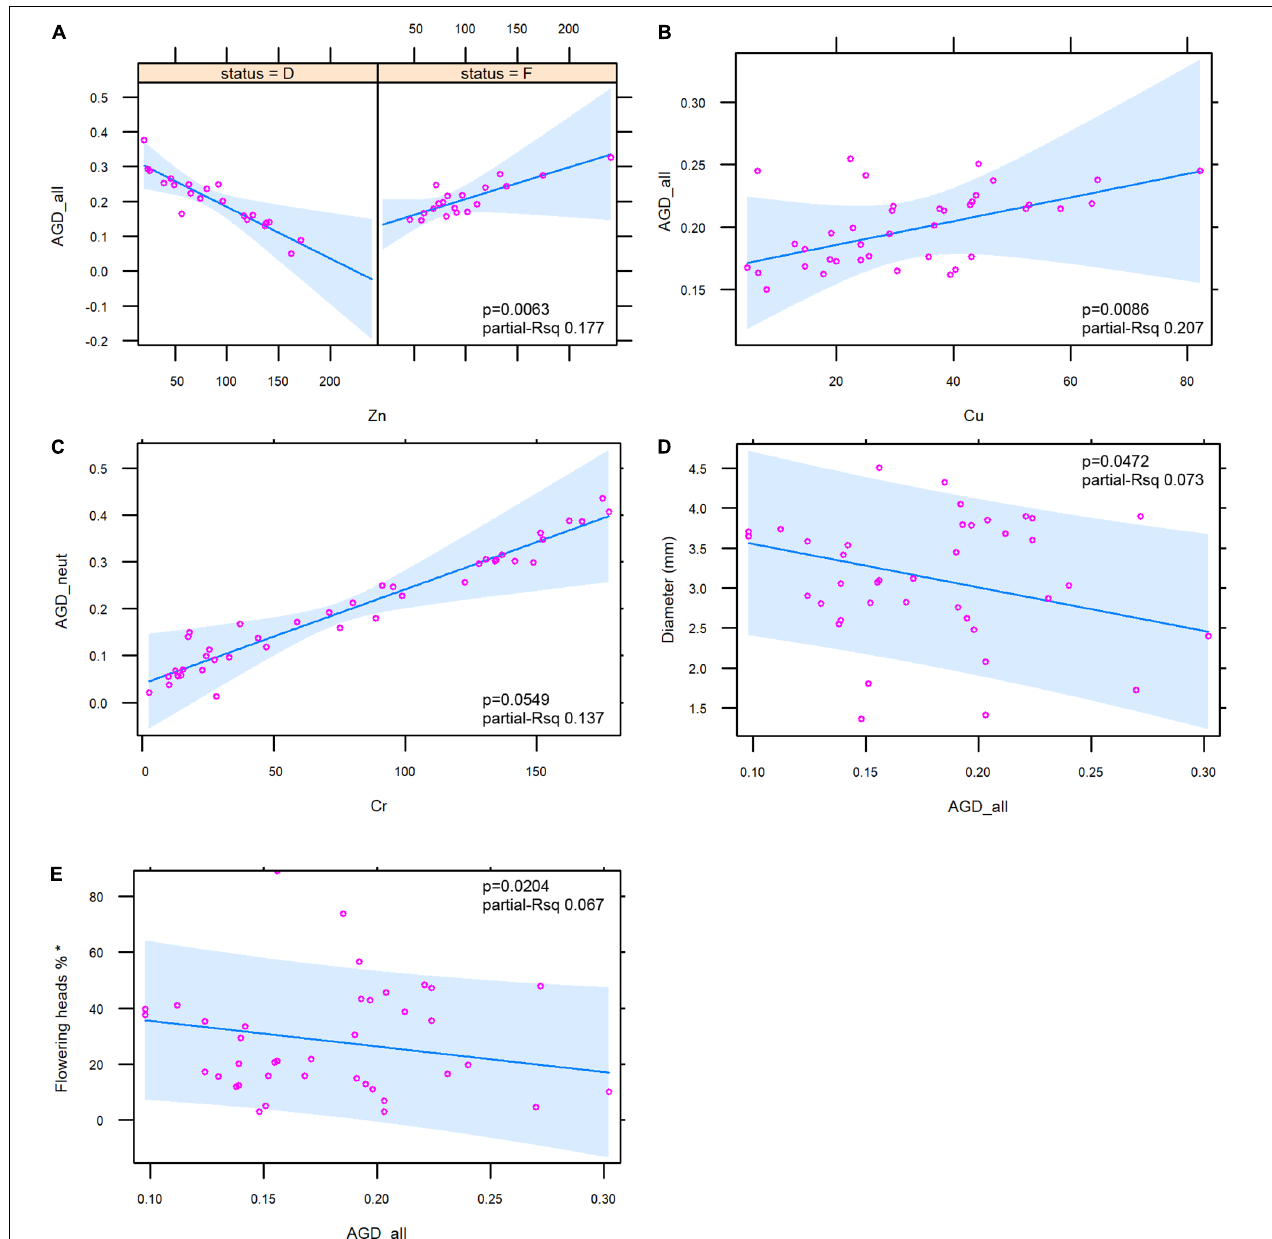
FIGURE 6 | Diagrams illustrating the relationships between the genetic diversity indices and sediment metals (6 A–C ) and macromorphological traits (6 D,E ). For Zn, the interaction with the ecological status (D = emerged; F = flooded stands) is shown. In each figure the ANOVA p -value and the partial R squared of the presented mixed models are shown. Variable marked with ∗ (E) was log-transformed in order to obtain the normality of